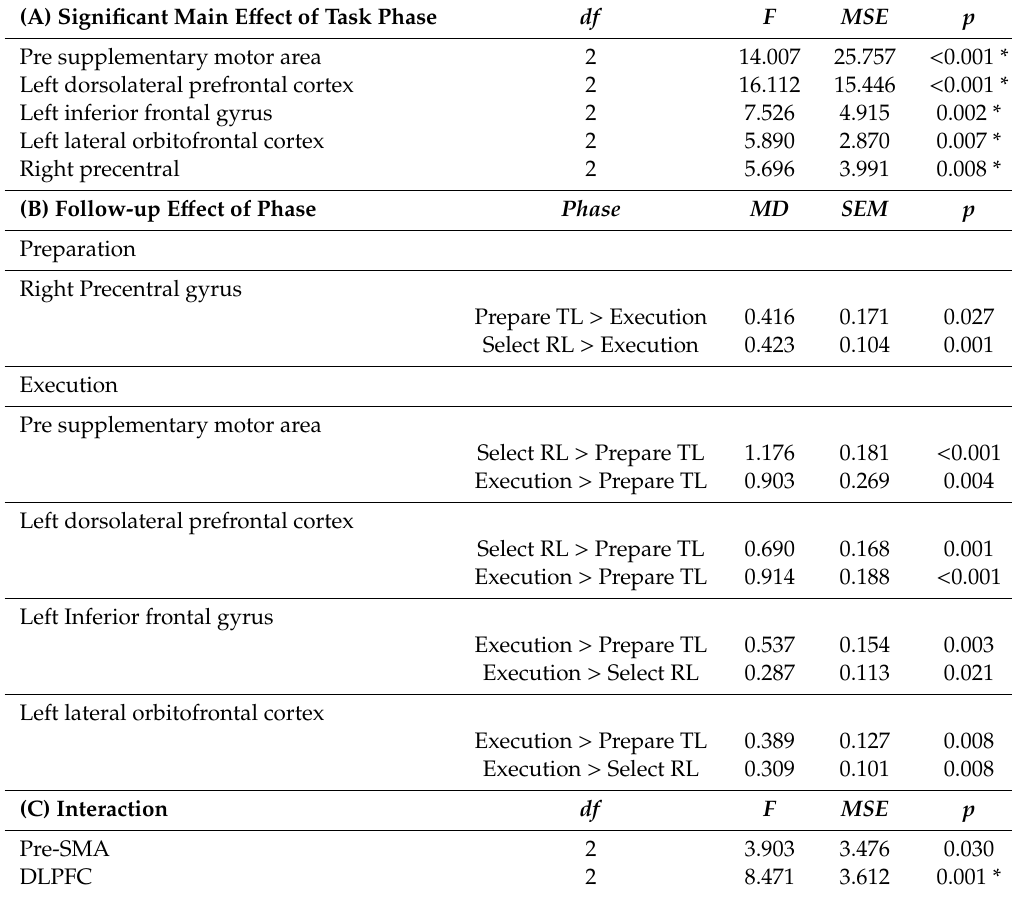
Table 5. Statistics from 2 × 2 × 3 repeated measures ANOVA and follow-up tests for cueing e ff ect and task phases on